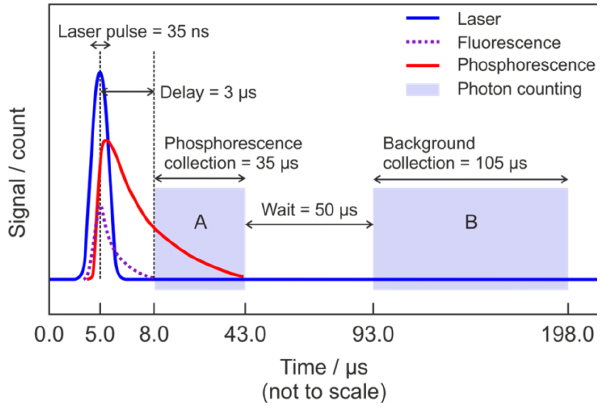
Figure 2. Schematic diagram showing the timing scheme for sig- nal acquisition. The start of the cycle (time = 0.0µs) is defined by the laser trigger. Blue is the Ti:Sapphire laser pulse at λ ∼ 440nm; dashed purple is the short-lived fluorescence from the cell anodis- ing dye, optics, and interfering species (e.g. NO 2 ); red is the gly- oxal phosphorescence; light (not to scale) blue shading is the pho- ton counting. Region A indicates the gate for measurement of the combined phosphorescence signal, remaining laser-scattered light signal and background signal, while region B indicates the gate for measurement of the background signal alone.